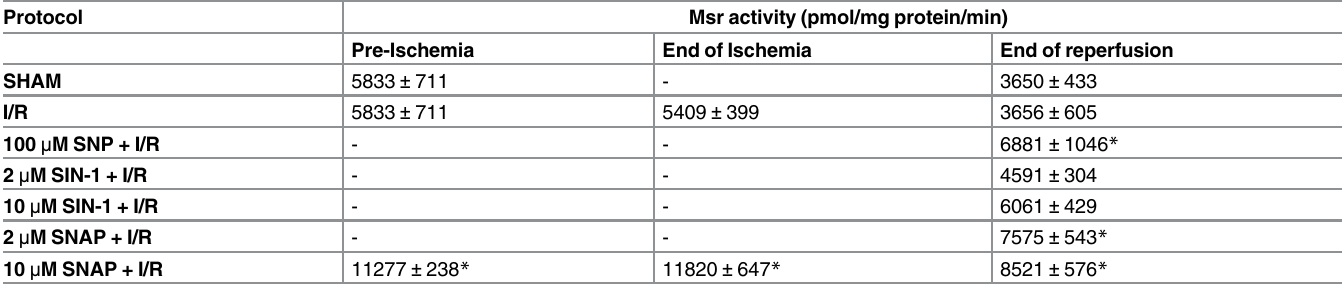
Fig 3. Infarct sizes of the rat hearts after exposure to the different experimental protocols. Data are presented as Mean ± SEM. * p < 0.05 versus I/R. doi:10.1371/journal.pone.0159951.g003 SNAP for 20 min, before prolonged ischemia and reperfusion, significantly reduced infarct size to (14.4 ± 1.7%; p < 0.05 vs. I/R). Treatment with 2 μ M SNAP (21.6 ± 2.0) %, 100 μ M SNP (23.7 ± 2.2) % or 10 μ M SIN-1 (23.3 ± 3.1) % had no infarct sparing effect. 2 μ M SIN-1 was found to significantly increase infarct size (34.8 ± 2.4%; p < 0.05) compared to I/R alone. Methionine-Centered Redox Cycle Msr activity (expressed as: pmol/mg protein/min) was not significantly different at the end of the reperfusion between the SHAM (3650 ± 433) and I/R groups (3656 ± 605) (Table 2). Perfu- sion with the NO-donors: 100 μ M SNP (6681 ± 1046), 2 μ M SNAP (7575 ± 543) or 10 μ M SNAP (8521 ± 576) significantly increased Msr activity compared to I/R alone (p < 0.01), as measured at the end of reperfusion. Concentration dependent effects on Msr activities can be observed after perfusions with 2 μ M and 10 μ M SNAP and SIN-1. Perfusion with SIN-1 did not significantly increase Msr activity compared to the I/R group. Furthermore, hearts perfused Table 2. Activities of methionine sulfoxide